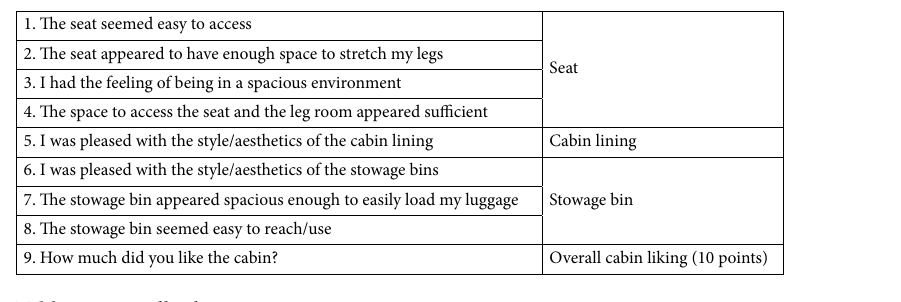
Table 1. Overall cabin scenario